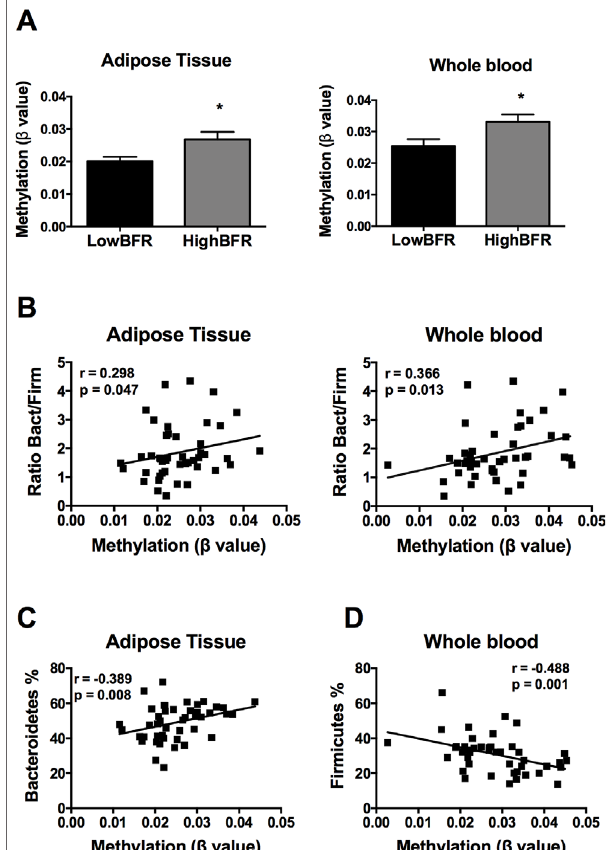
FIGURE 3 | Association between the DNA methylation status of histone deacetylase 7 (HDAC7) and the gut microbiota composition in obese subjects. (A) Methylation of HDAC7 ( β value) in the HighBFR vs. LowBFR groups in both visceral adipose tissue and whole blood. Data ( n = 10 per group) are plotted as means ± SE. Significance was tested using Mann– Whitney U test and is indicated as * p < 0.05. (B) Spearman correlations between HDAC7 methylation and the ratio Bact/Firm in both visceral adipose tissue and whole blood. (C) Spearman correlation between HDAC7 methylation and the relative abundance (%) of Firmicutes in whole blood. (D) Spearman correlation between HDAC7 methylation and the relative abundance (%) of Bacteroidetes in visceral adipose